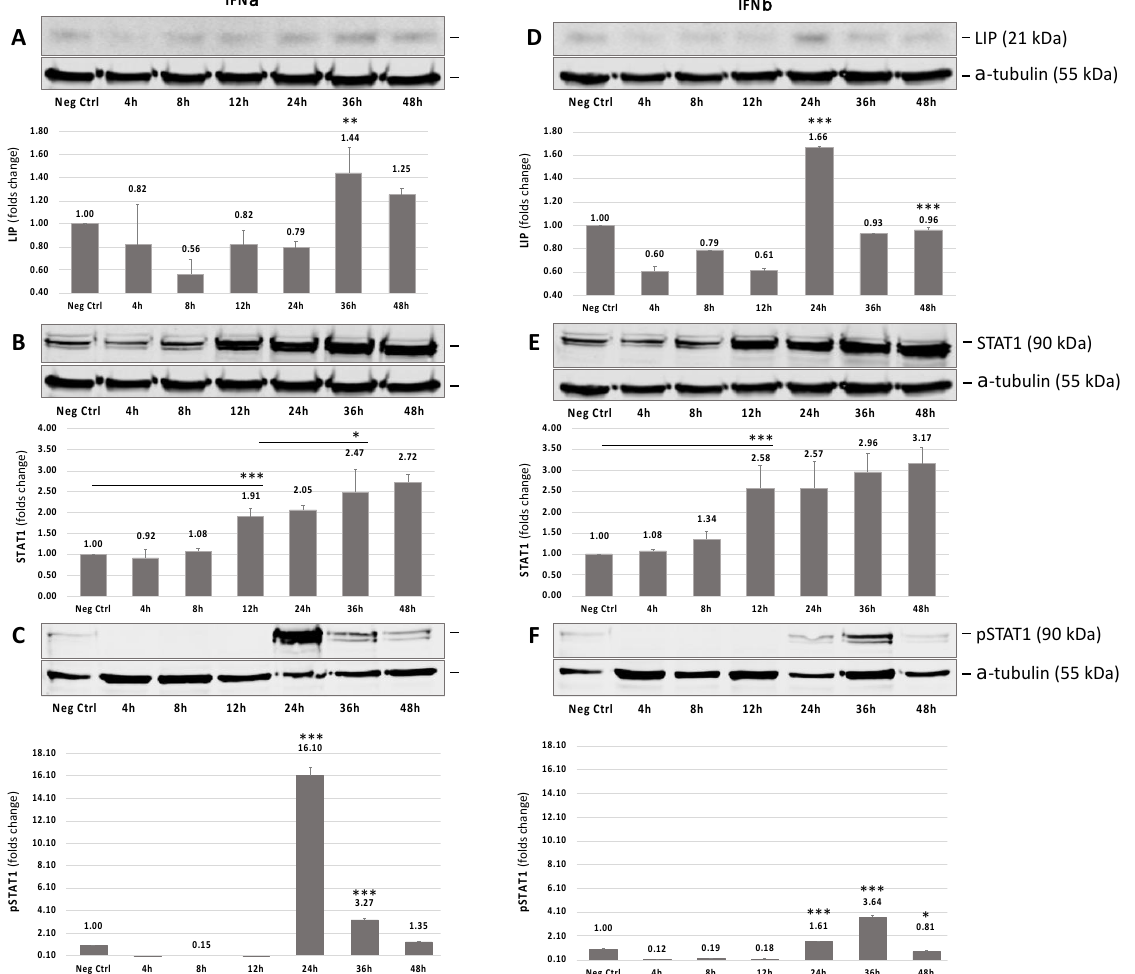
Figure 1. Endogenous expression of c/EBP β -LIP (LIP) after treatment with IFN α or IFN β . Western blot on protein lysis from SVGA cells collected 4, 8, 12, 24, 36 and 48 h after a single treatment with IFN α ( A – C ) or IFN β ( D – F ), respectively, in order to evaluate the endogenous expression of LIP ( A , D ). α -tubulin was used as loading control and endogenous expression of STAT1 ( B , E ) and its phosphorylated form ( C , F ) (phosphoSTAT1 or pSTAT1) were also analyzed. For each panel, a densitometry assessment of LIP and STAT1 was also included, using untreated SVGA cells as negative control. At 36 and 24 h there was a significant increase in endogenous expression of LIP after treatment with IFN α ( p < 0.01) and IFN β ( p < 0.0001), respectively, whereas an important increasing of STAT1 phosphorylation was observed at 24 and 36 h after treatment with IFN α and IFN β , respectively. Standard deviation bars are depicted on the graph. p values <0.05 were considered statistically significant. Note: * p <0.05; ** p < 0.01; *** p < 0.0001.